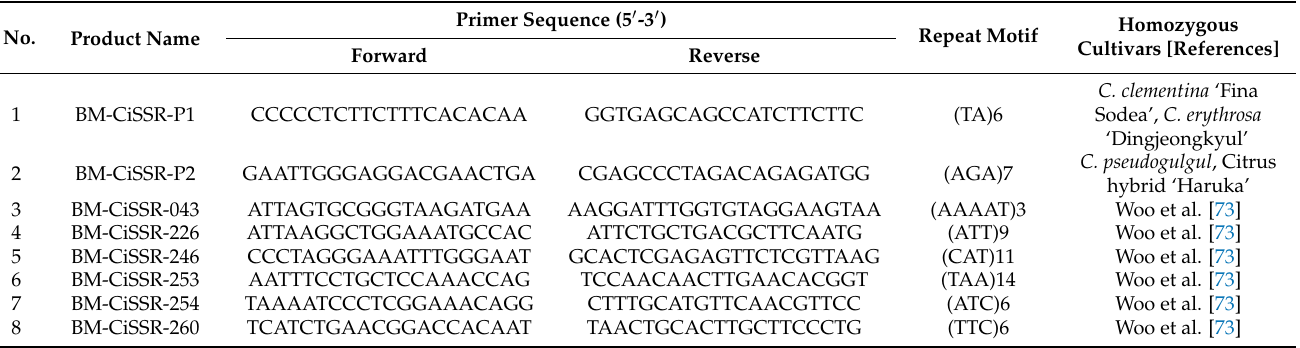
Table 1. Nucleotide sequence and repeat motifs of the simple sequence repeat markers used in the